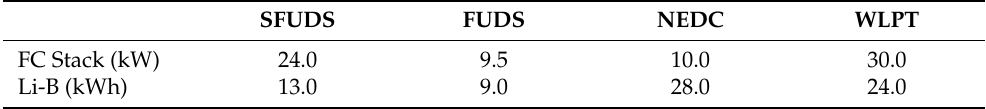
Table 4. H-ESS design solutions (Psplit2): δ = 1.